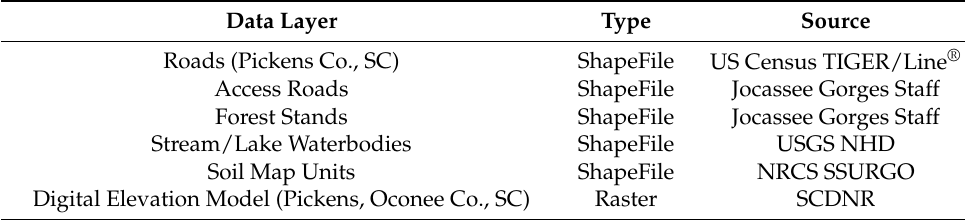
Table 2. Data layers acquired for the HOI model in Jocassee. Data Layer Type Source Roads (Pickens Co., SC) ShapeFile US Census TIGER/Line ® Access Roads